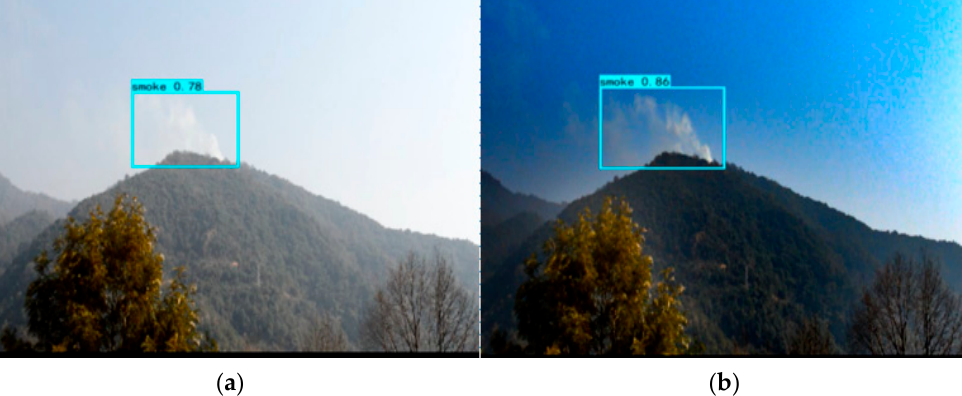
Figure 9. Comparison of target confidence of forest fire in foggy environment by ( a ) YOLOX-L-Light and ( b ) GLXD.